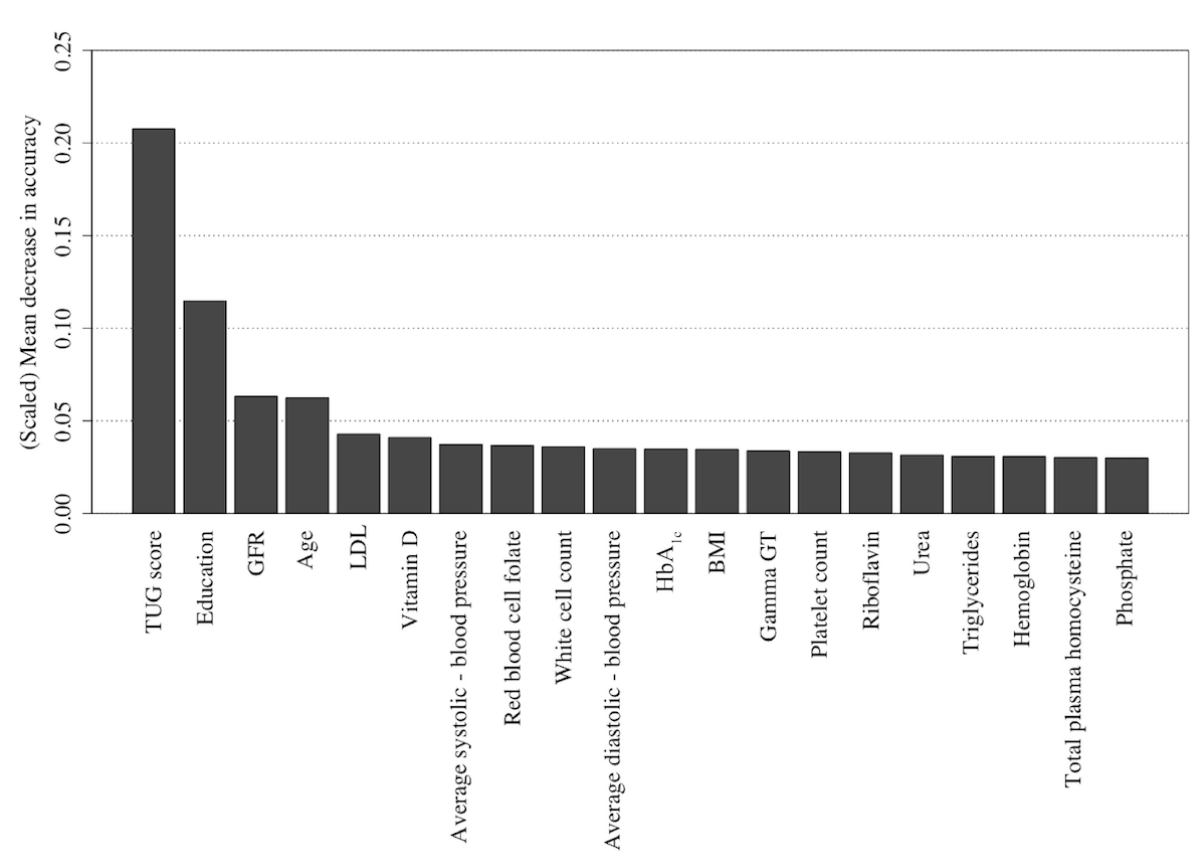
Figure 11. The 20 most important features for classification of the Repeatable Battery for the Assessment of Neuropsychological Status score as detected using feature permutation using a random forest classifier. GFR: glomerular filtration rate; HbA1c: glycated hemoglobin; LDL: low-density lipoprotein; TUG: Timed Up and Go.